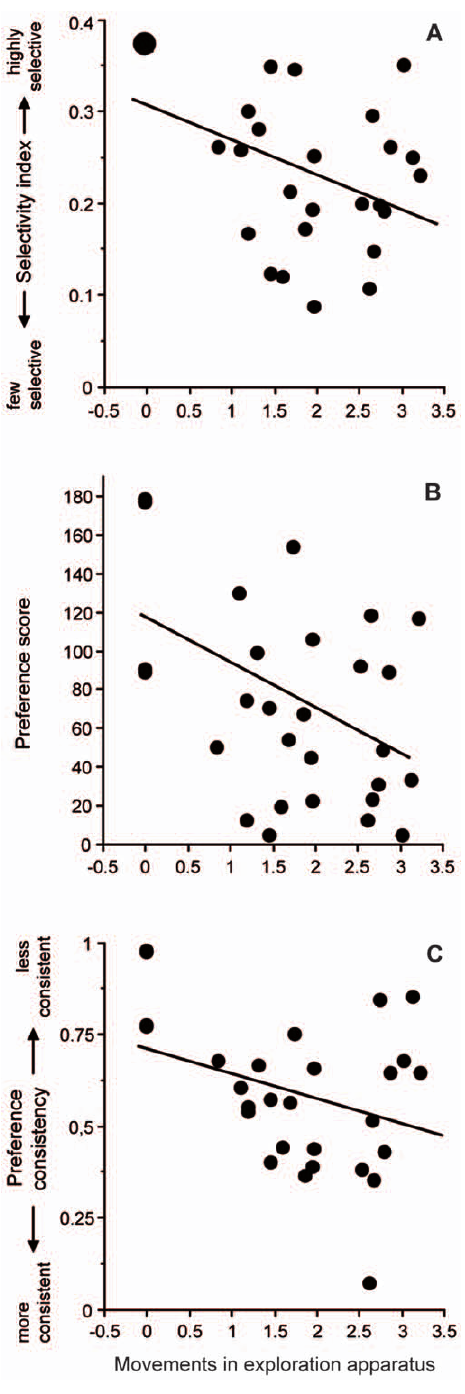
Figure 3. Influence of exploration tendencies on mate-choice components: selectivity index (A), average preference score for the preferred male (B), and preference consistency (C). X-axis scale has been transformed to reach normality.